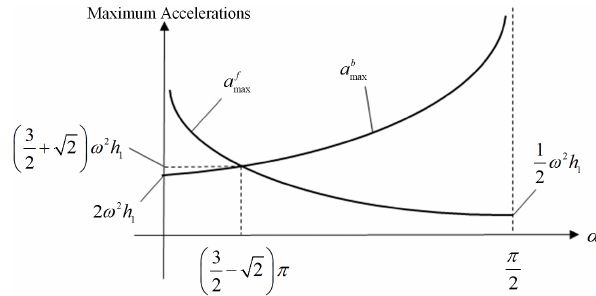
Figure 7. Piston maximum accelerations respect to transition an- gles ( α ) of the two-piston pump.